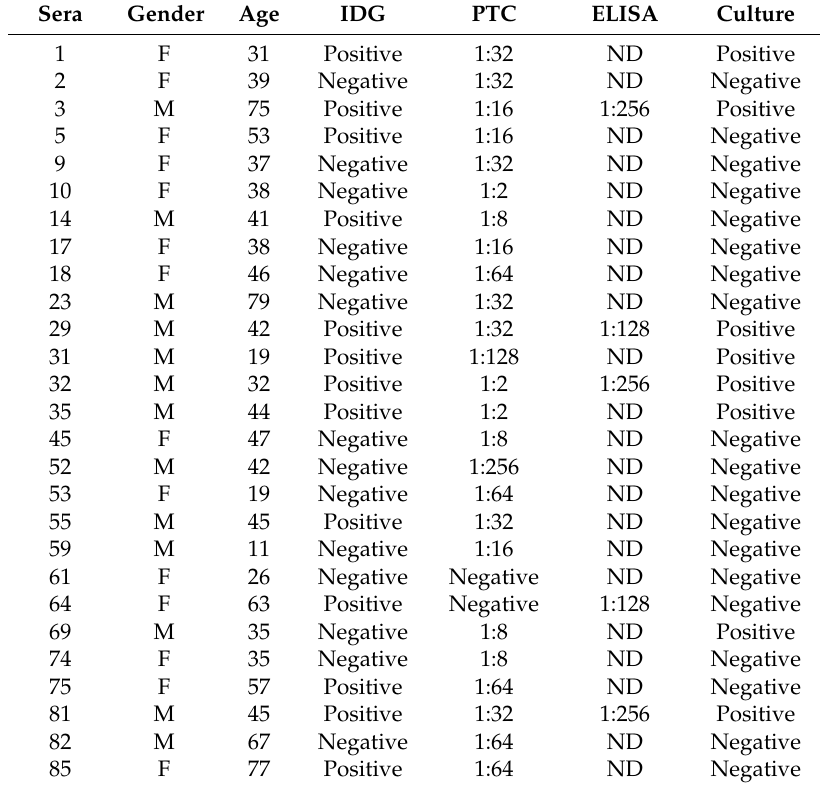
Table 5. Serum samples from patients with acute pulmonary or disseminated coccidioidomycosis.